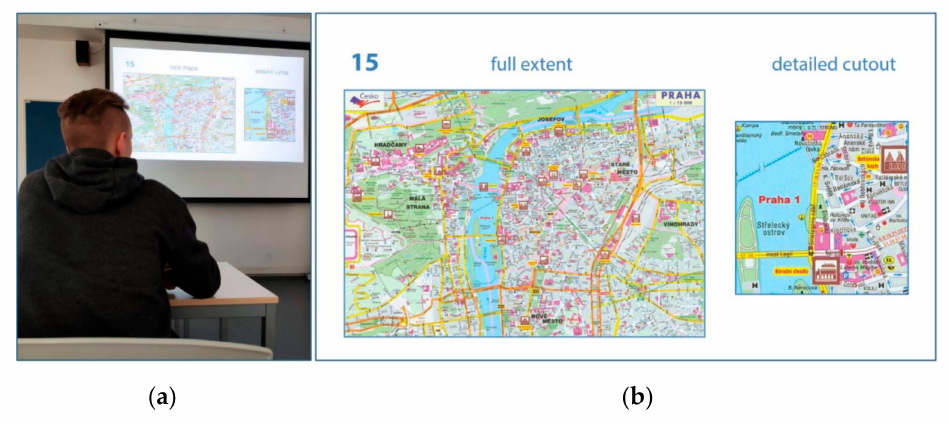
Figure 1. User experiment in progress ( a ) with an example of map stimuli in its second phase ( b